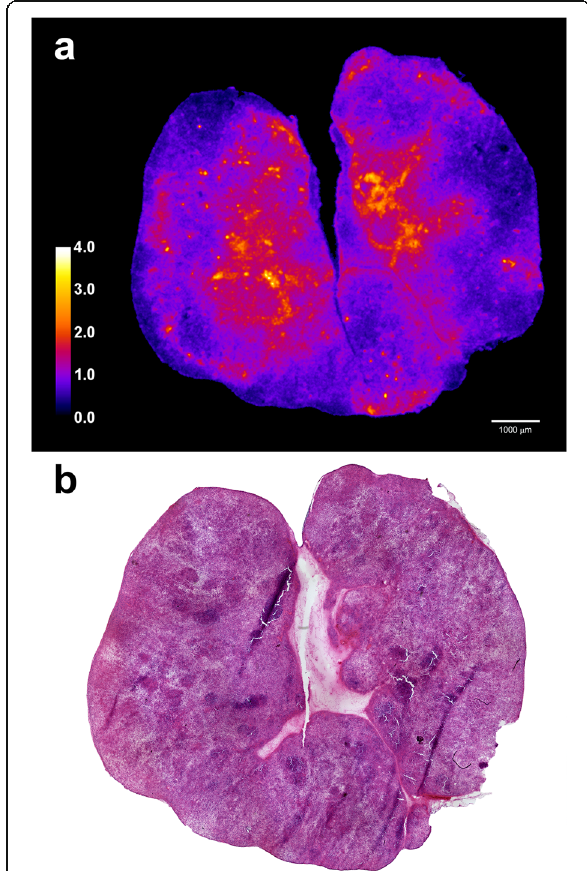
Fig. 2 The intratumoral activity distribution of 211 At-A11 in s.c. PSCA- PC3 macrotumors at 3 hpi ( a ) as studied by alpha camera imaging [22]. The color coded LUT is normalized so that 1.0 represent the mean activity for the whole tumor section. White scale bar indicate 1000 μ m. Consecutive H&E-stained section ( b ). LUT look-up-table; H&E Hematoxylin and